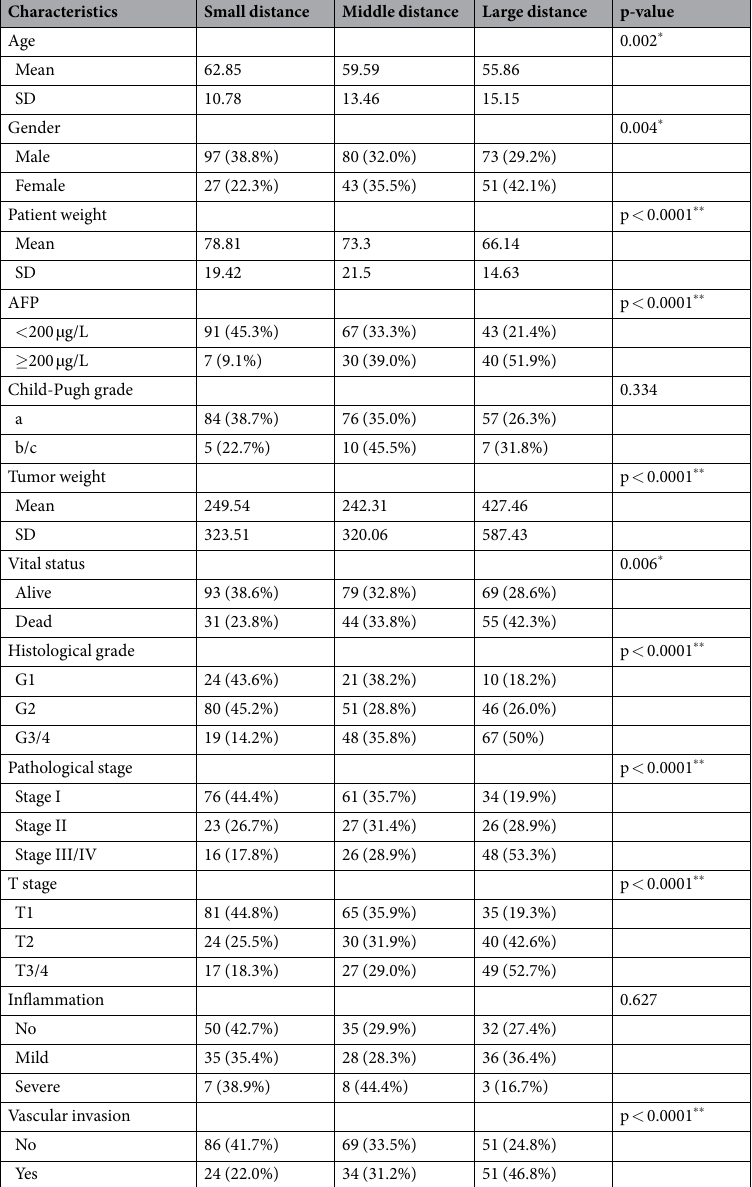
Table 2. Relationship between mean expression distance and clinical characteristics of patients with HCC. All ordinal data were analyzed with nonparametric statistics as appropriate. Statistical significance is marked with the star symbol: * p < 0.01, ** p <